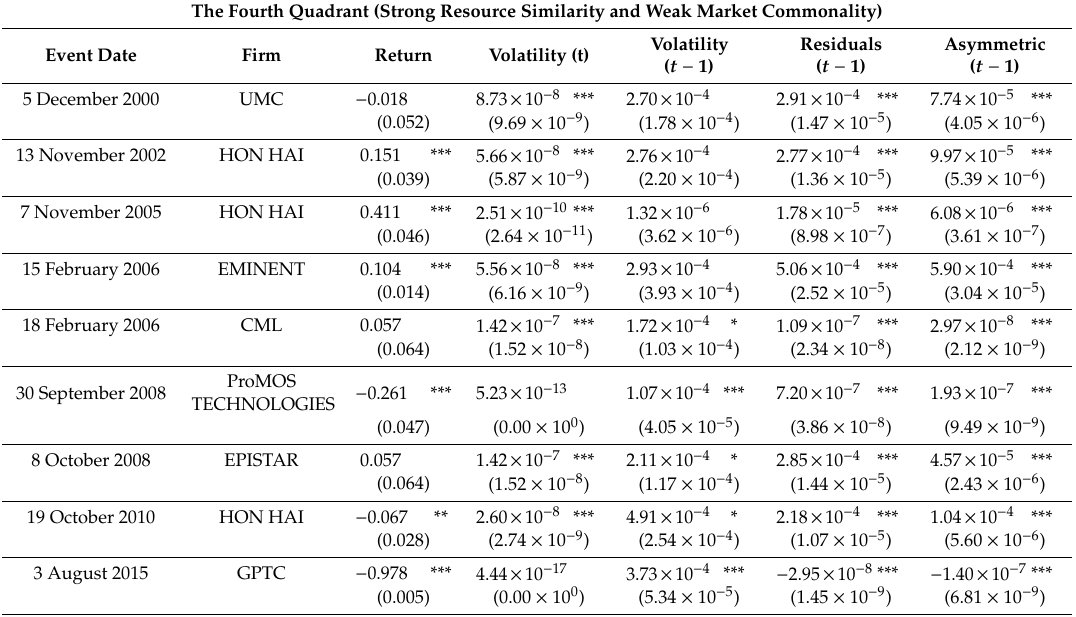
Table 5. Fourth quadrant estimation results of GJR-GARCH after projection dynamic